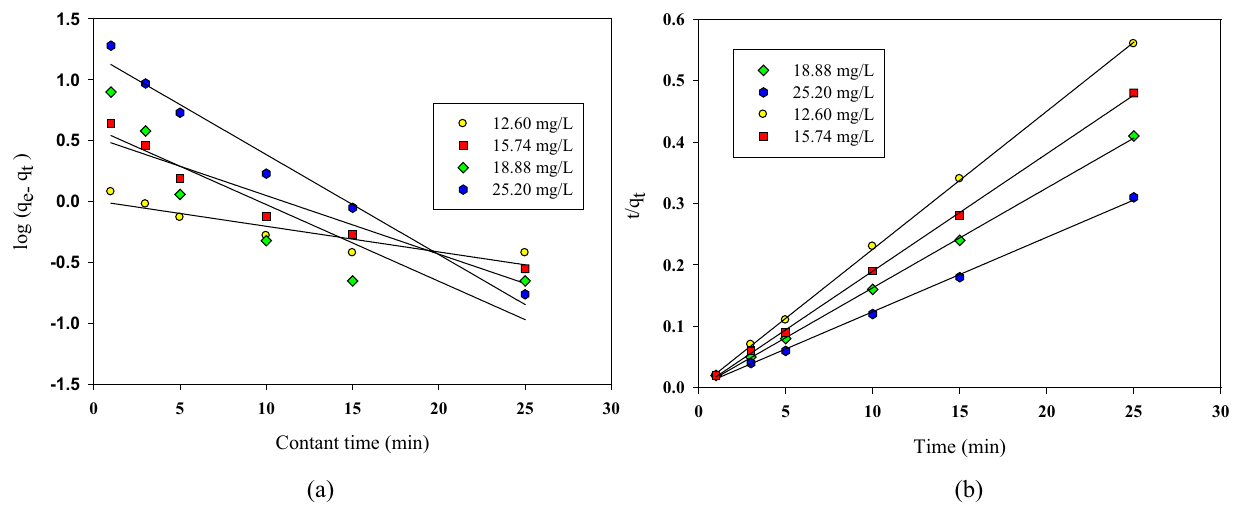
Fig. 3 a Plot of log ( q q e – t ) versus contact time to investigate the pseudo-first order kinetics for adsorption of methylene blue solu- tions on coconut coir dust. b Plot of t / q t versus time to investigate the